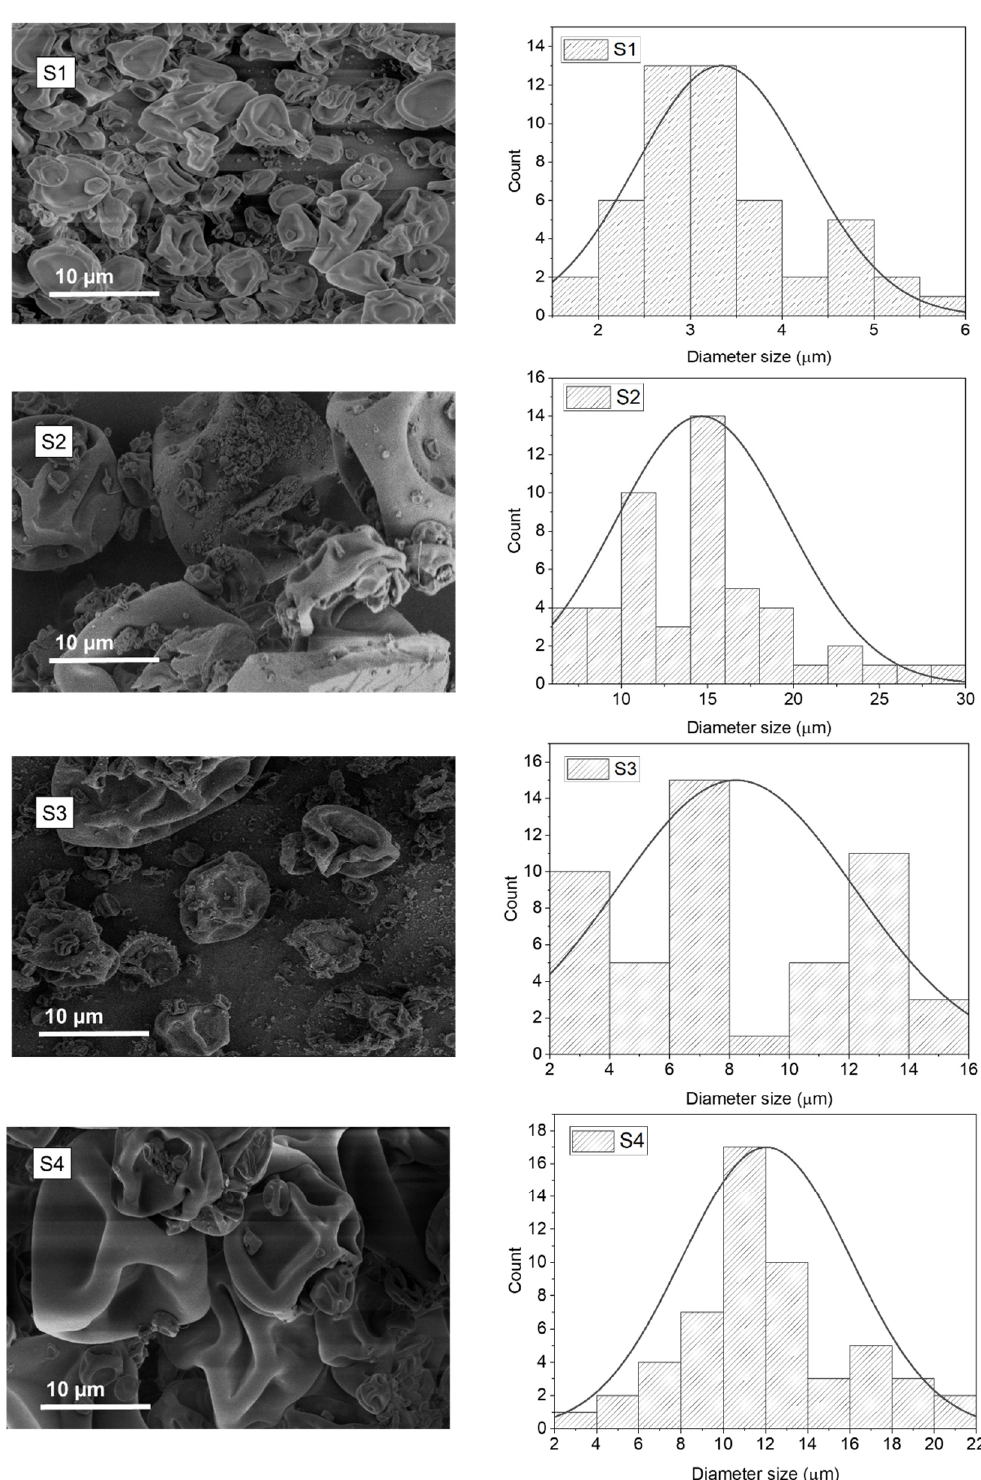
Figure 2. SEM images of ETC core–shell capsules loading Bifido (samples S1 – S4 ) and respective histograms displaying microcapsules diameter distribution.